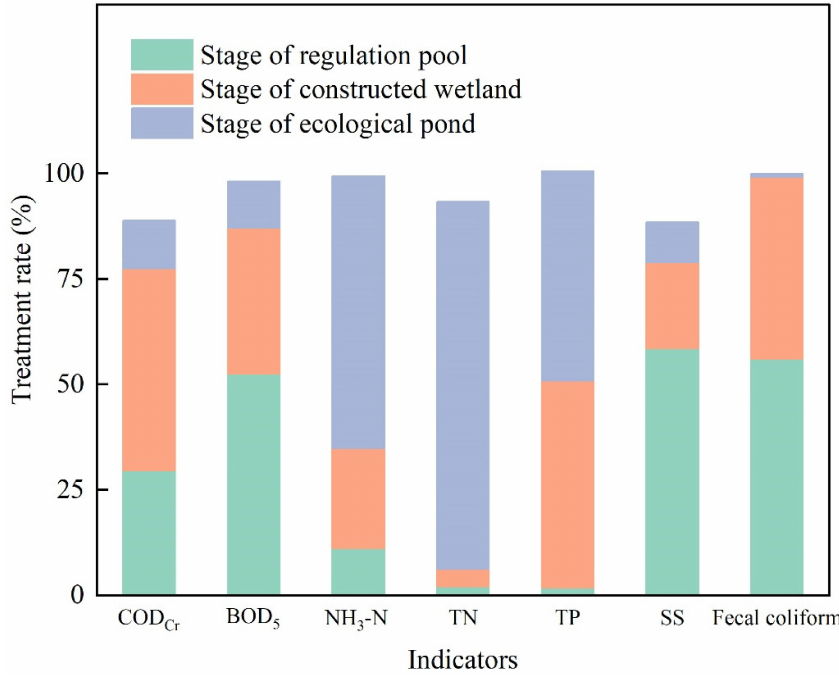
Figure 3. Treatment rate of pollutants at each stage of the sewage treatment project. The changes in the concentrations of pollutants in the influent and effluent at each stage of sewage treatment are shown in Figures 4 and 5. In general, the indicators of the various pollutants gradually decreased, but the treatment effects on the different pollutants differed in the different treatment